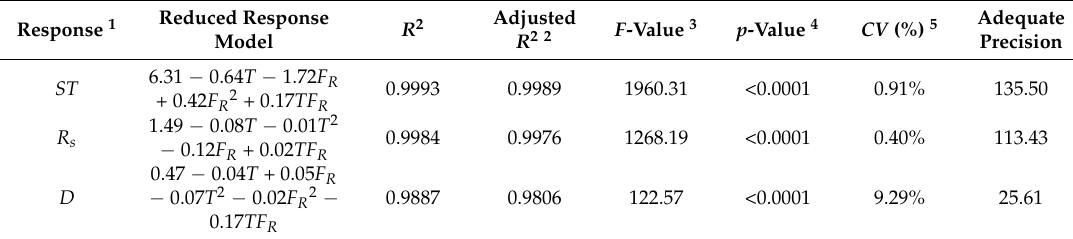
Table 2. Response models and statistical parameters obtained from